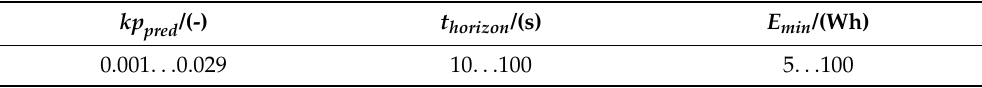
Table 5. Range of parameter studies of the predictive Online ECMS. kp /(-) t horizon pred